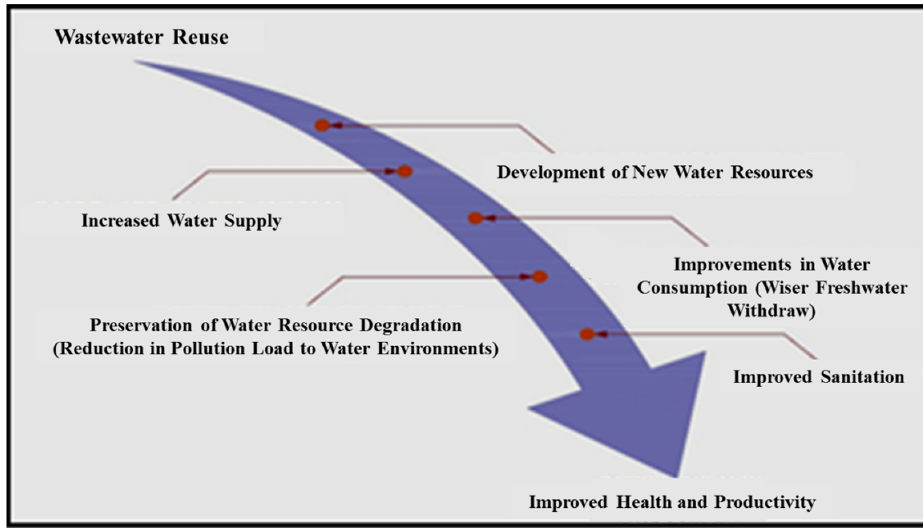
Figure 3. Prospects of reuse of wastewater or sewage/domestic water protecting environmental health risks modified from [93].